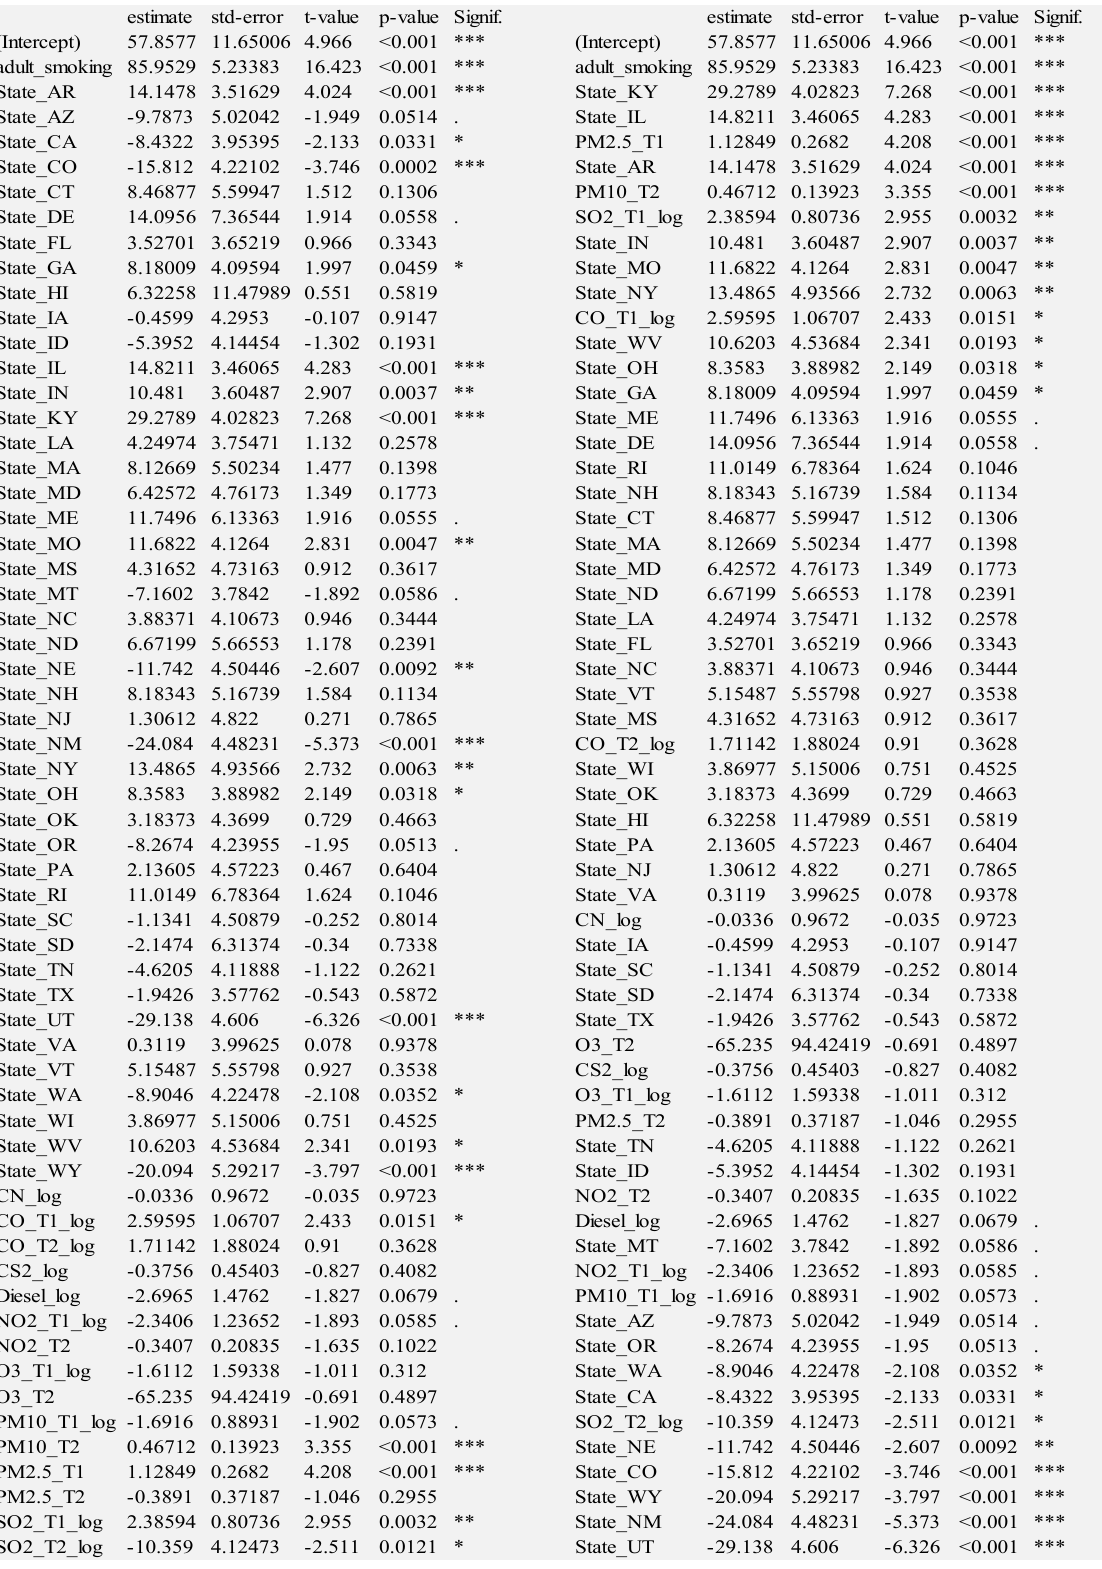
Figure 9. Foundation + Ambient Emissions; Residual standard error: 10.62 on 2228 degrees of freedom; Multiple R-squared: 0.613, Adjusted R-squared: 0.6026 ; F-statistic: 58.82 on 60 and 2228 DF, p -value: < 2.2 × 10 − 16 ; Significance codes: 0 ‘***’ 0.001 ‘**’ 0.01 ‘*’ 0.05 ‘.’ 0.1 ‘ ’